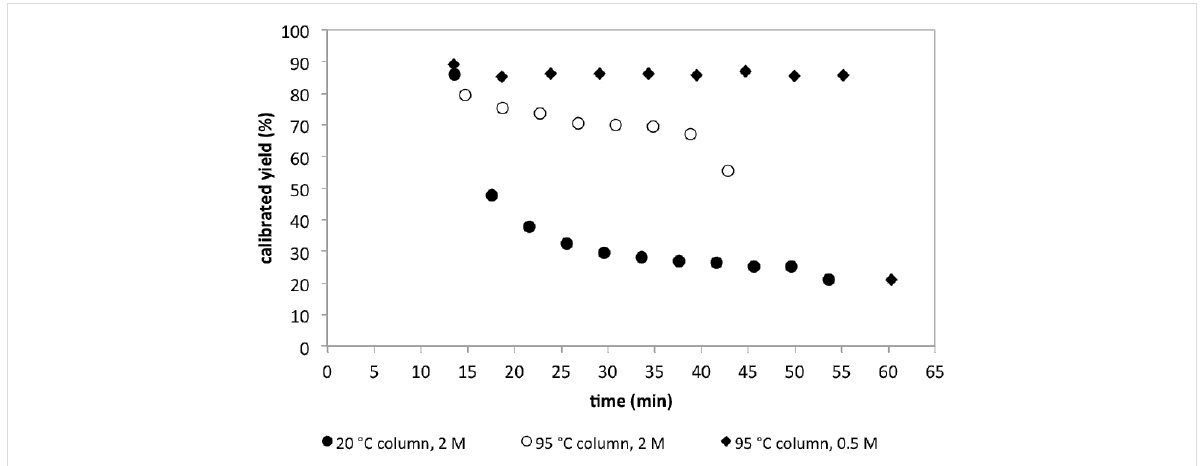
Figure 3: Comparing the long-term stability of the Al 2 O 3 and 3 Å MS columns when the Al 2 O 3 column temperature (20 °C and 95 °C) and Knoeve- nagel reaction concentration (2.0 M and 0.50 M) are varied. The time between 0 and 13 min was the equilibration period.